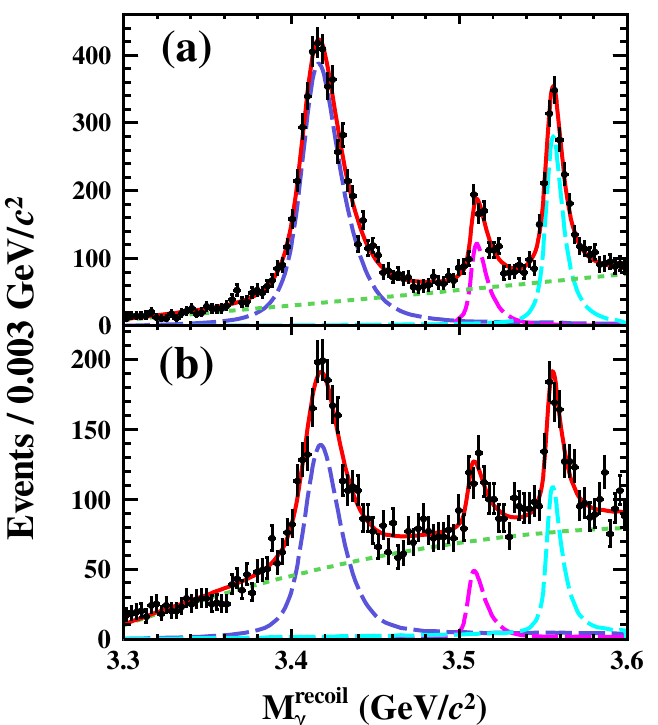
Figure 2 . Fit of the M recoil distributions for the (a) χ cJ → Ξ − ¯Ξ + and (b) χ cJ → Ξ 0 ¯Ξ 0 processes. γ Dots with error bars are data, the solid lines show the fit results, the long dashed lines represent the signal contributions, and the short dashed lines represent the smooth backgrounds.